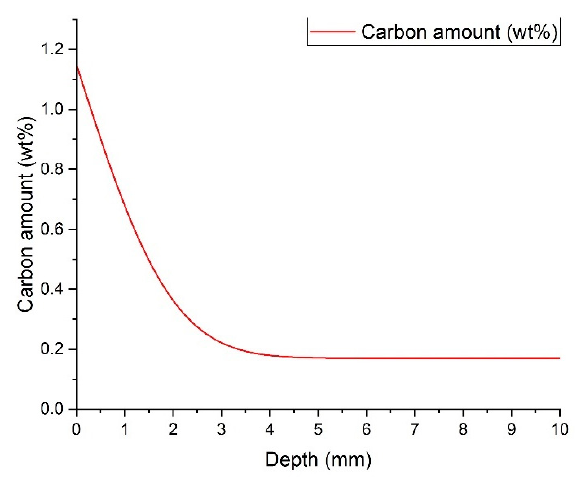
Figure 2. Carbon amount.